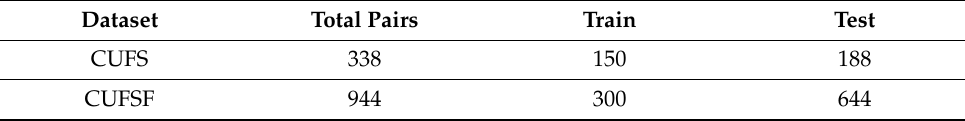
Table 3. Distribution of synthesized sketches by the NLDA procedure of face